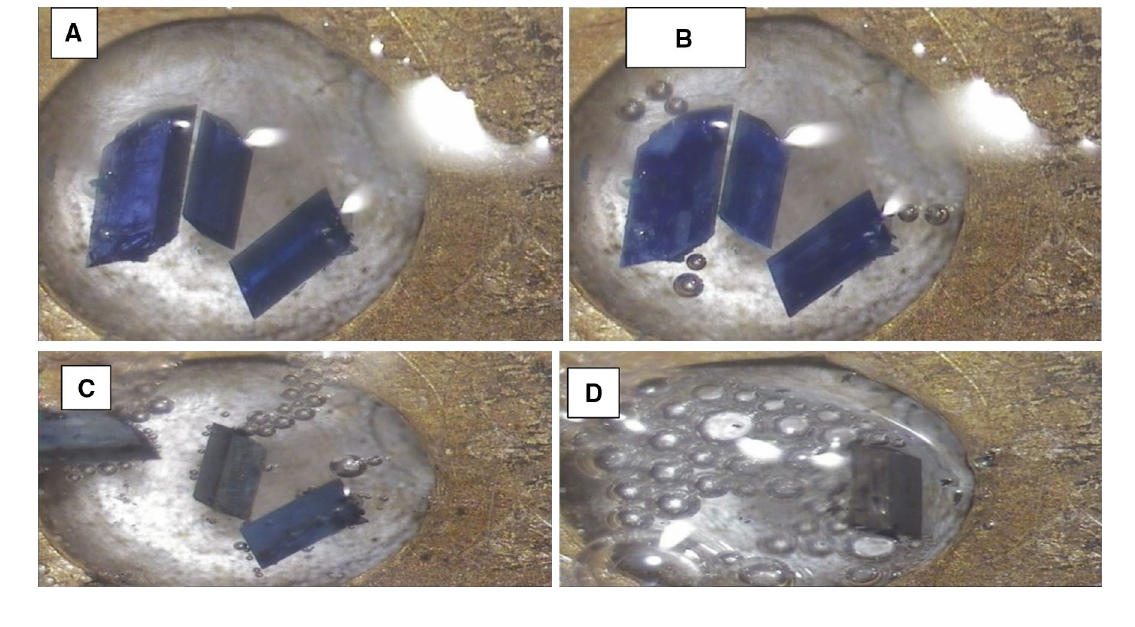
Fig. 6 a – d HSM of CP-1